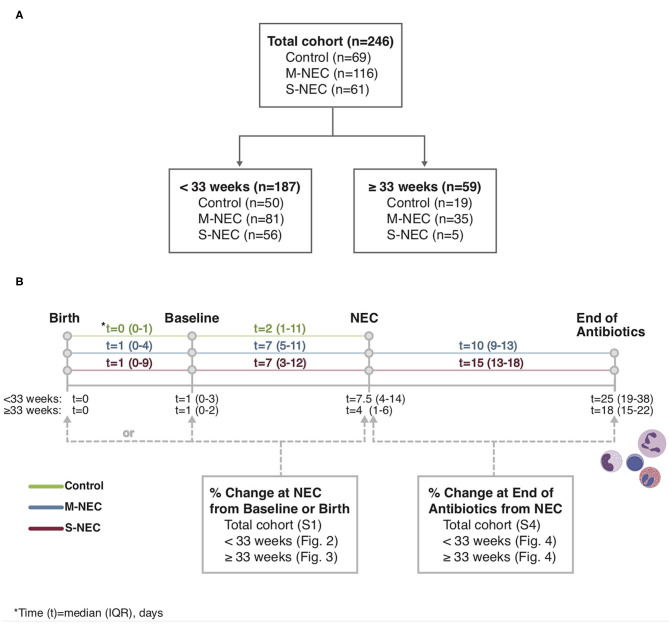
Study flowchart (A) and timeline (B). Complete blood count (CBC) values obtained at birth, baseline, necrotizing enterocolitis (NEC) diagnosis, and the end of the antibiotic course were recorded from the electronic medical record.